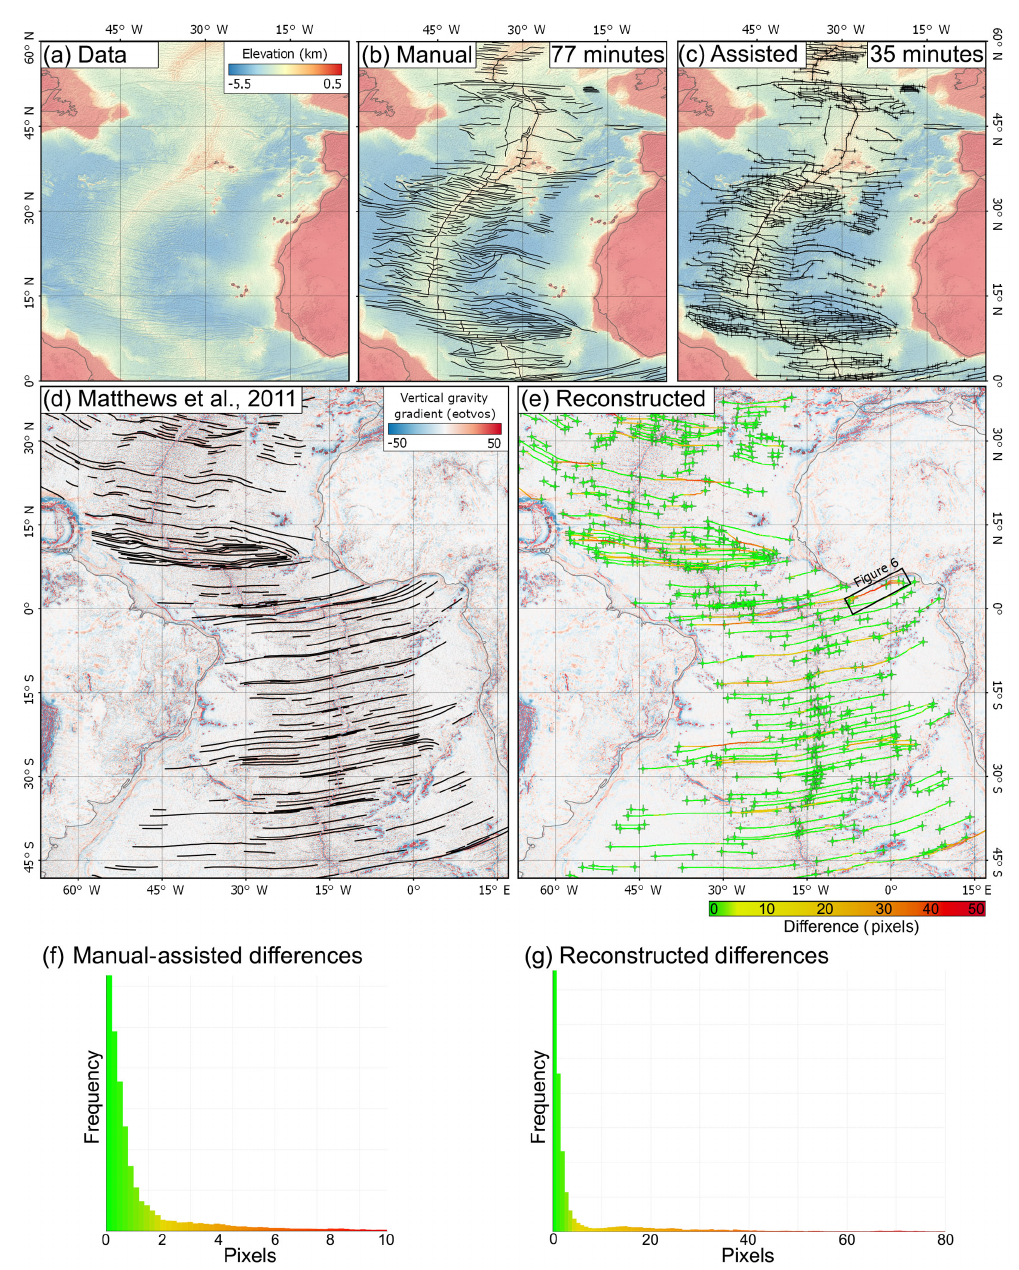
Figure 5. Bathymetry showing oceanic fracture zones in the North Atlantic (a) and associated manual (b) and assisted (c) interpretations. Fracture zones interpreted manually (d) from vertical gravity gradient by Matthews et al. (2011) and reconstructed in GeoTrace using the start and end points only (e) are also shown. As in the previous case studies, most equivalent manual and assisted traces fall within 2 pixels (f) , though differences of up to 80 pixels occur in the reconstructed dataset (g) . The location of Fig. 6 is shown in (e) for